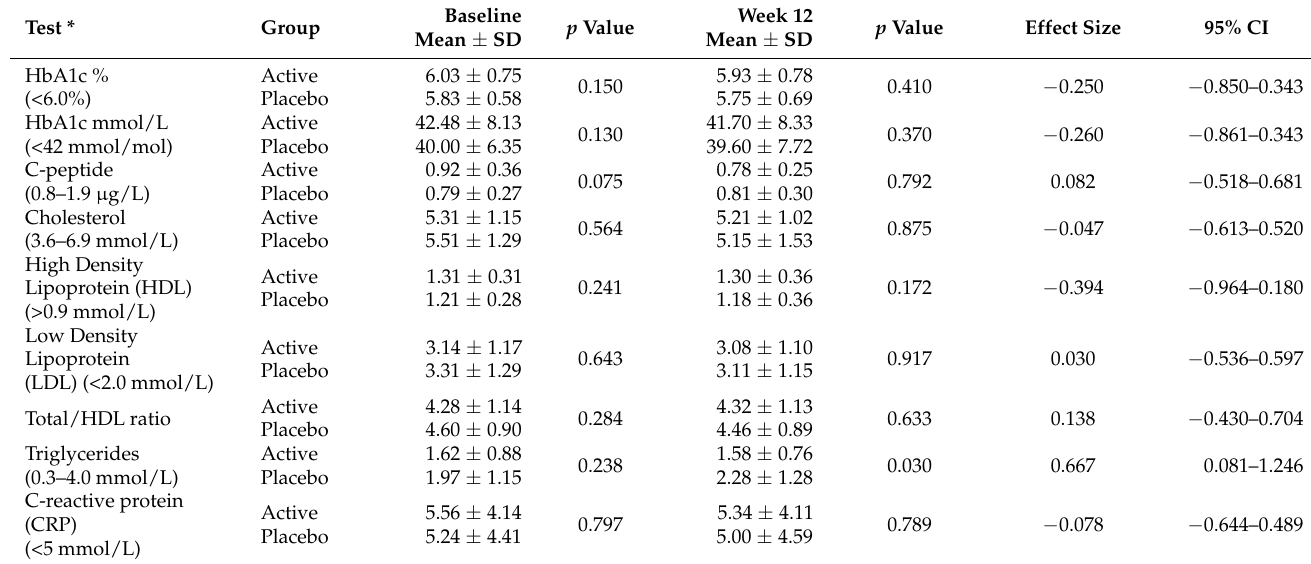
Table 3. HbA1c, C-peptide, lipid profile, atherogenic potential and C-reactive protein for Active treatment and Placebo at baseline and week 12.